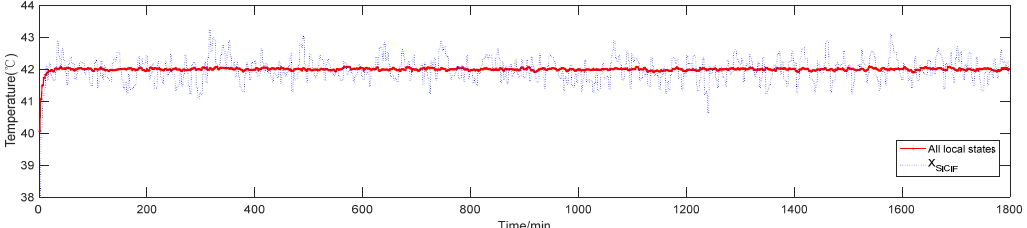
Figure 11. Simulation results of local measurement fusion estimation in each cluster: ( a ) Tank1, ( b ) Tank2, ( c ) Tank3.